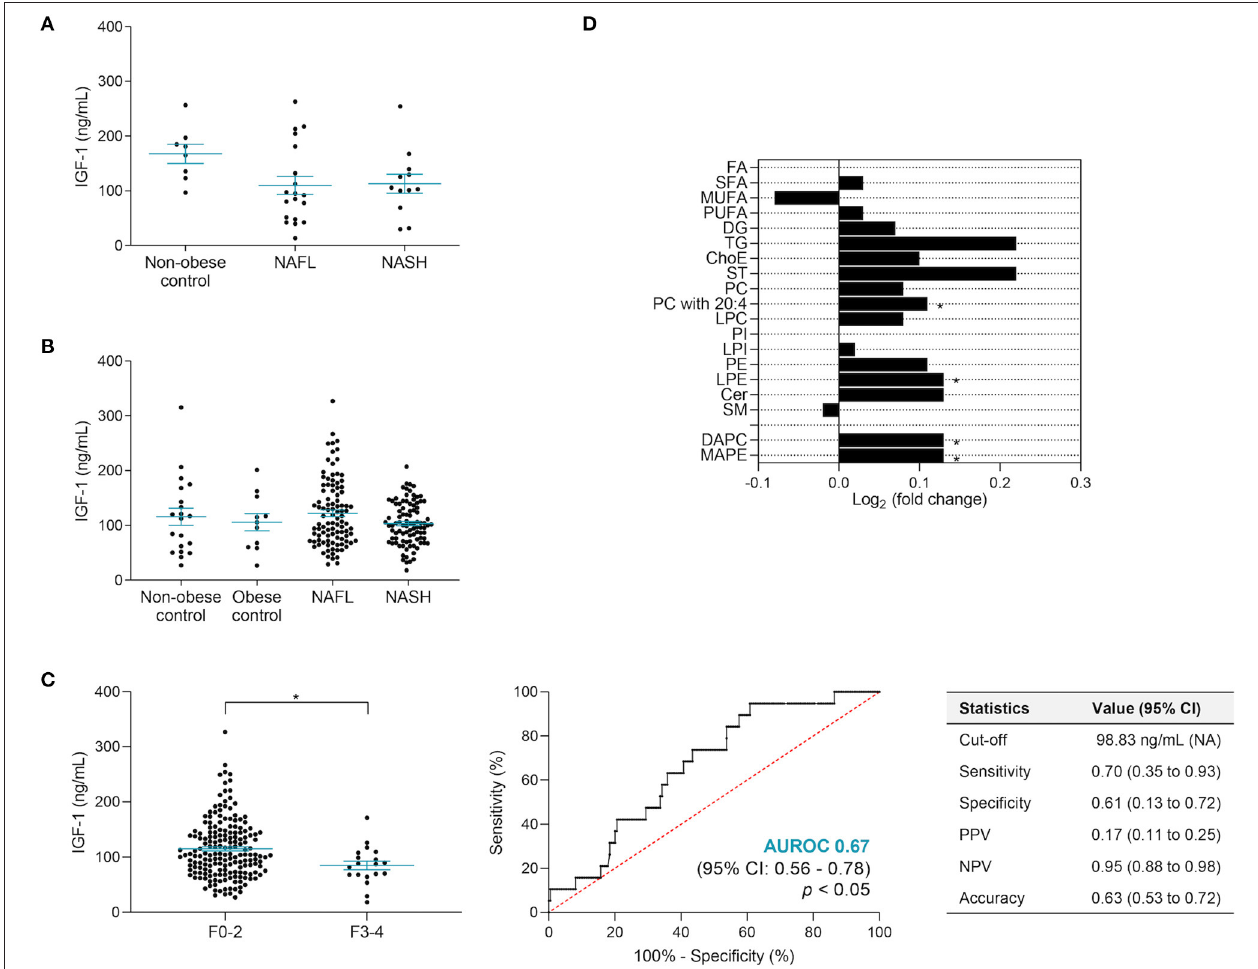
FIGURE 4 | IGF-1 serum levels correlated with liver fibrosis score. (A) In the discovery cohort, the IGF-1 serum levels were slightly lower in NASH patients compared to NAFL and non-obese contros. (B) No significant differences in IGF-1 levels were found among controls and patients with NAFLD in the validation cohort. (C) In the validation cohort, NAFLD patients with advanced fibrosis presented significantly lower levels of IGF-1. The x -axis represents fibrosis score dichotomy: none to moderate fibrosis (F0-2; n = 184) and advanced fibrosis to cirrhosis (F3-4; n = 19). IGF-1 alone presents an AUROC value of 0.67 when distinguishing F0-2 vs. F3-4. (D) Serum lipidomic signature associated with higher IGF-1 circulating levels. Data presented as log 2 of the fold change between higher vs. lower than the median IGF-1 level (103.65ng/ml). Higher, n = 97; lower, n = 97. IGF-1 levels depicted as mean ± SEM. Cer, ceramide; ChoE, cholesteryl ester; CI, confidence interval; DAPC, diacylglycerophosphocholine; DG, diglyceride; FA, fatty acid; IGF-1, insulin-like growth factor 1; LPC, lysophosphatidylcholines; LPE, lysophosphatidylethanolamines; LPI, lysophosphatidylinositols; MAPE, monoacylglycerophosphoethanolamine; MUFA, monounsaturated FA; NAFL, non-alcoholic fatty liver; NASH, non-alcoholic steatohepatitis; NPV, negative predictive value; PPV, positive predictive value; PC, phosphatidylcholines; PE, phosphatidylethanolamines; PI, phosphatidylinositols; PUFA, polyunsaturated FA; SFA, saturated FA; SM, sphingomyelins; ST, steroids; TG, triglycerides; 20:4, arachidonic acid. * p < 0.05.